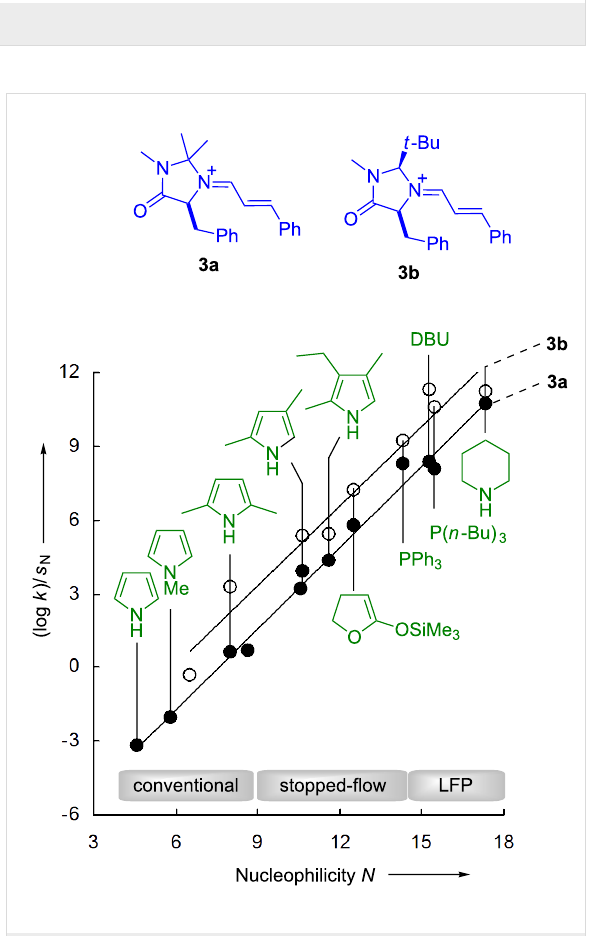
Figure 4: Laser flash photolytic generation of iminium ions 3a .